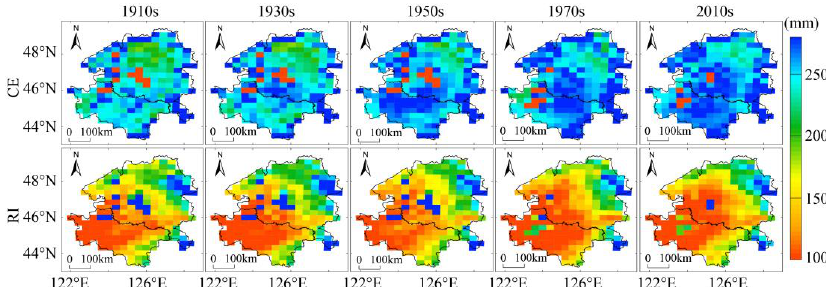
Figure 9. The centurial patterns of the canopy transpiration ( CE) and runoff and infiltration ( RI) in the study region. Maps in the 1980s, 1990s and 2000s are not shown because of their visual similarities with the 1970s and 2010s.